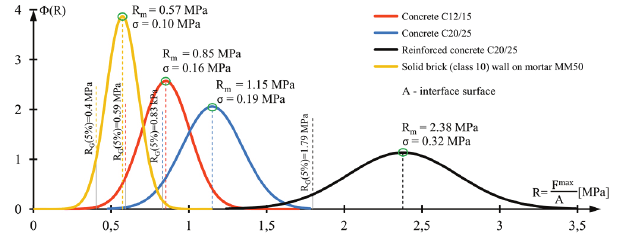
Fig. 14. Probability distribution of strength of connection between pile and the part modelling various types of foundations The following symbols have been adopted: F max is the maximum force obtained in experiment, R m and R G (5%) are the mean and guaranteed values, respectively, at 5% strength of connection,  is a standard deviation, A is the contact